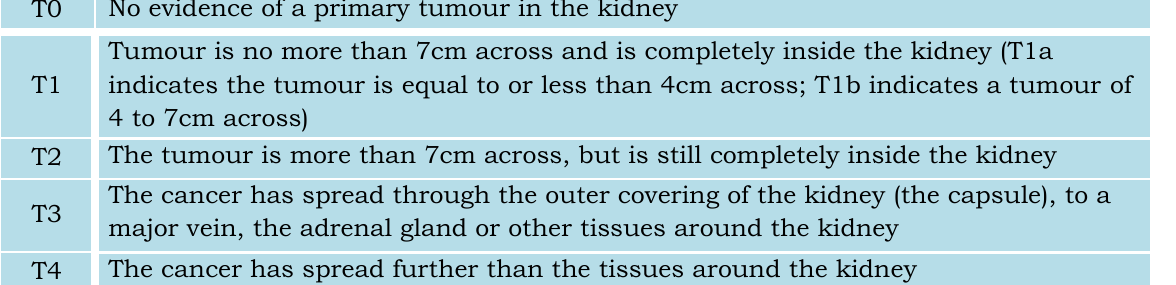
Table 1. Tumour (T) stages of kidney cancer in the TNM system of classification